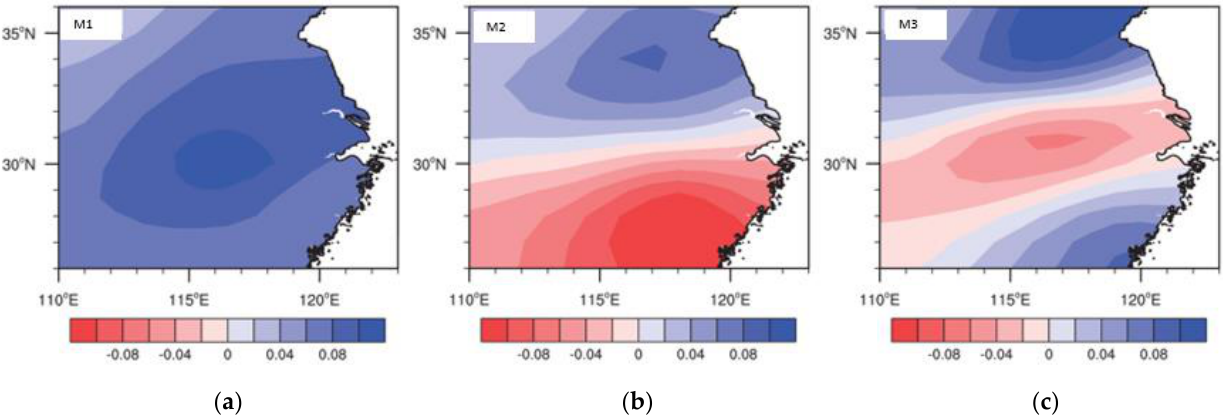
Figure 2. The three lead EOF modes ( a – c ) of persistent heavy rain in the Jianghuai Basin.